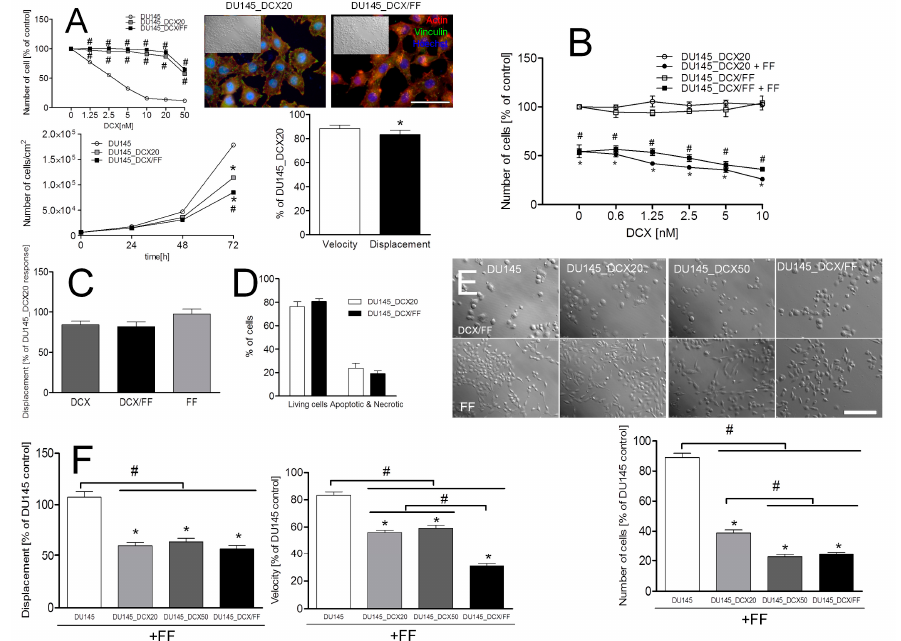
Figure 6. Long-term DCX/FF treatment of prostate cancer cells does not prompt their DCX/FF- Long-term DCX/FF treatment of prostate cancer cells does not prompt their resistance. ( A ) DCX-resistance and phenotypic properties of DU145_DCX/FF cells. DU145_DCX/FF